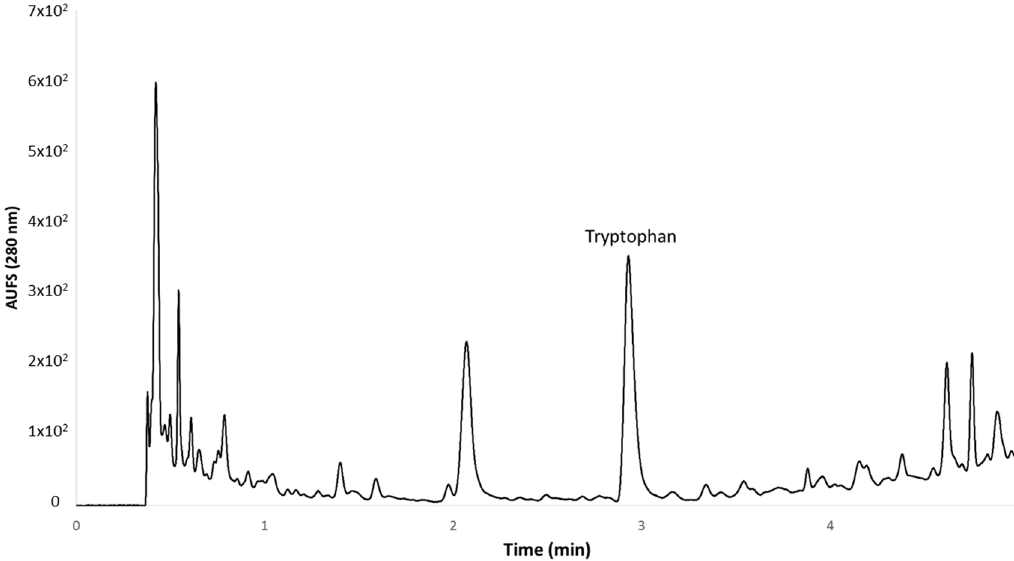
Figure 4. Typical chromatogram from a grape sample during the ripening period.